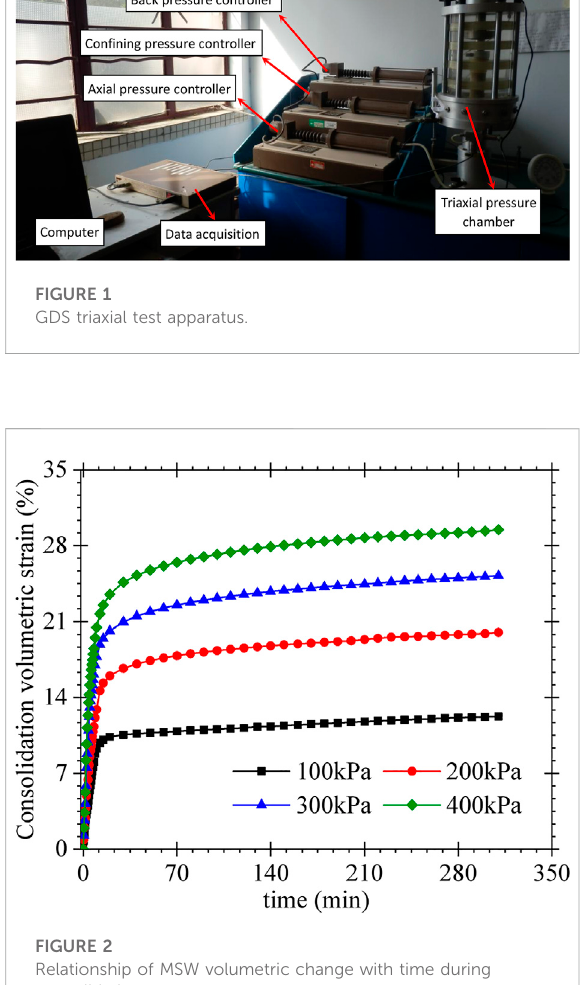
Relationship of MSW volumetric change with time during